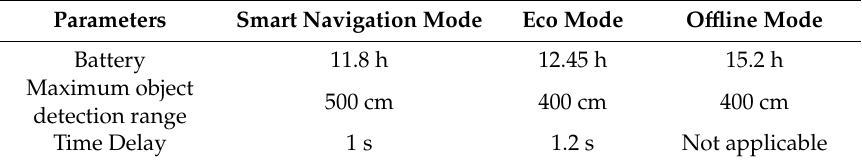
Table 3. Performance of navigation